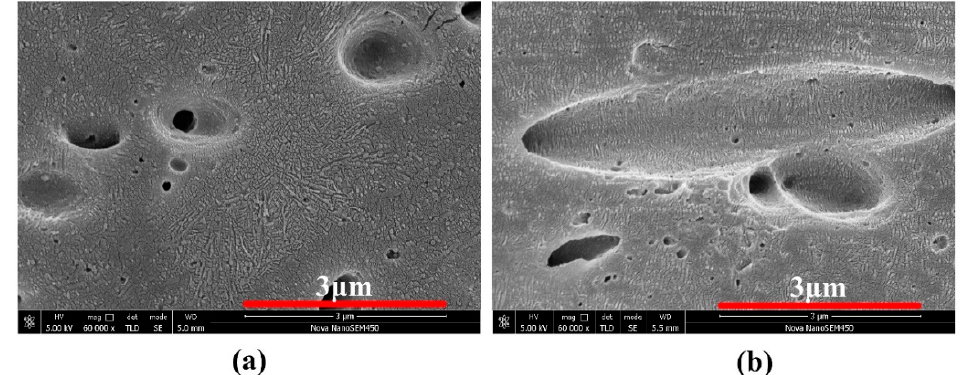
Figure 3. SEM images show the crystal structures of ( a ) BC5, and ( b ) MV5.